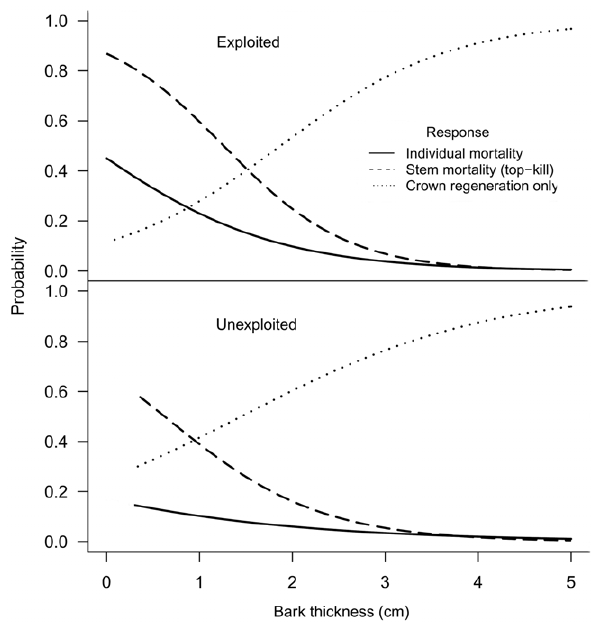
Figure 3. Post-fire Q. suber responses as a function of bark thickness and exploitation status. Post-fire Q. suber responses as a function of bark thickness and exploitation status based on overall models in Table 2 (DBH is held constant at 21 cm, representing the average tree; this size corresponds to the beginning of the productive life for exploited trees).